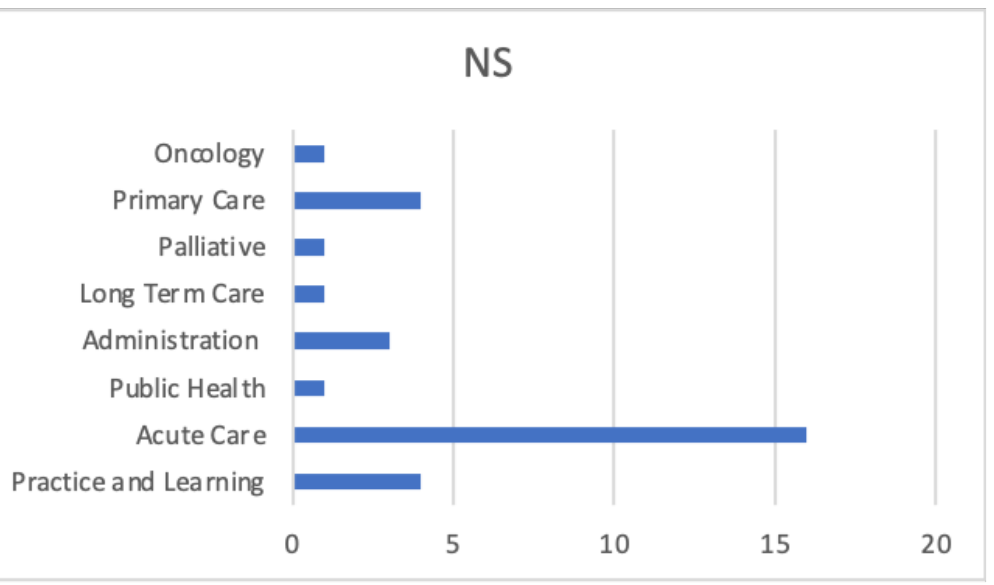
Figure 3: Place of Nurse Employment Profile of Saskatchewan